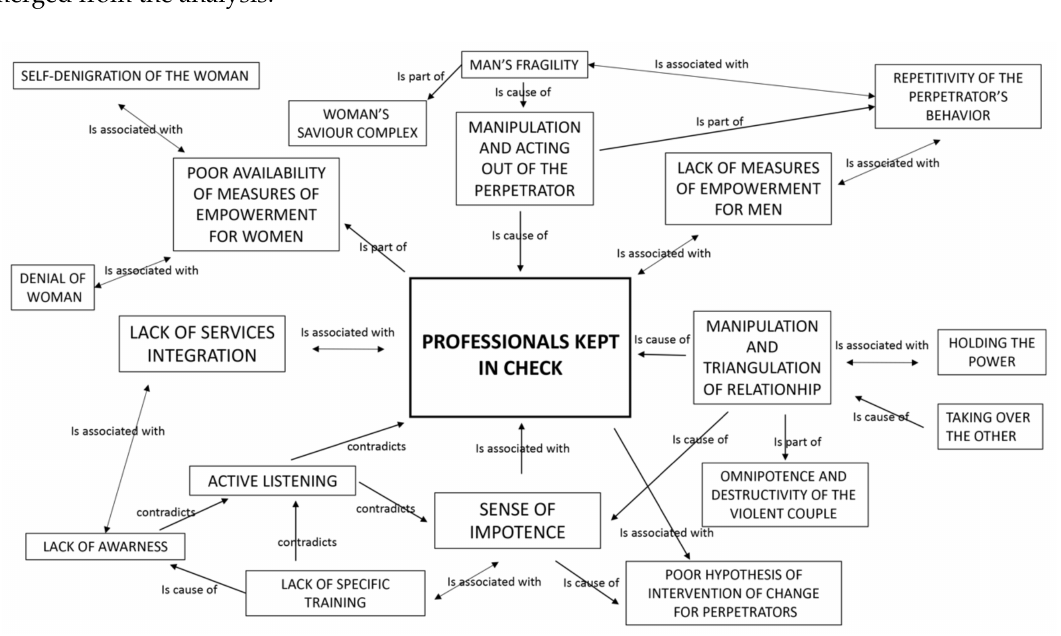
Figure 1. Network and core category “professionals kept in